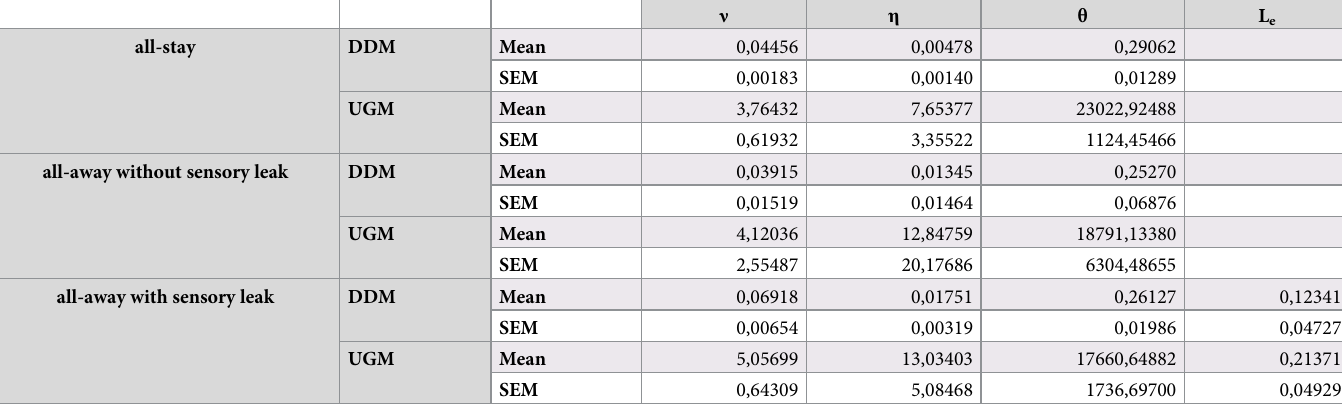
Table 1. Mean and SEM across subjects of the best fitting parameters for the EAM and the UGM in the all-stay and all-away conditions with and without leakage in the sensory evidence.